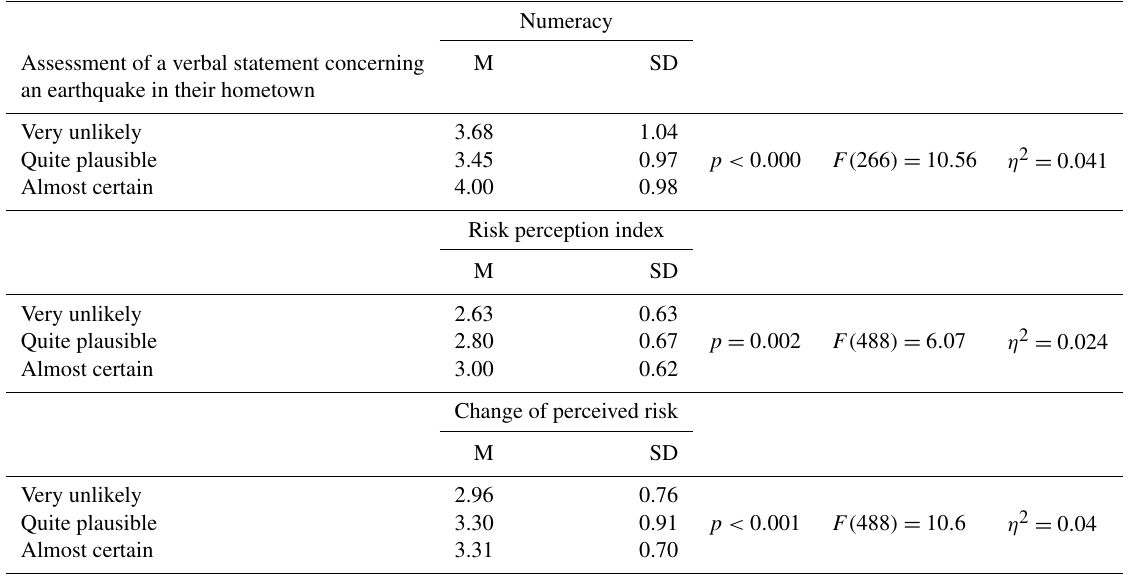
Table 12. Univariate analysis of variance with numeracy, the risk perception index, or the change of perceived risk as dependent variable and the assessment of a verbal statement concerning an earthquake in their hometown as independent variable ( N =